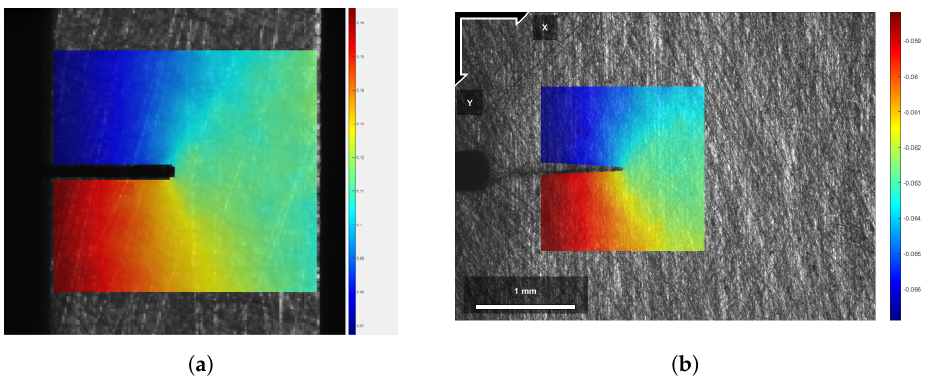
Figure 5. Examples of displacement fields obtained after removal of bubbles during monotonic and cyclic testing. ( a ) Vertical displacement field during SSRT testing. ( b ) Vertical displacement field √ during cyclic testing with ∆ K = 18MPa m.